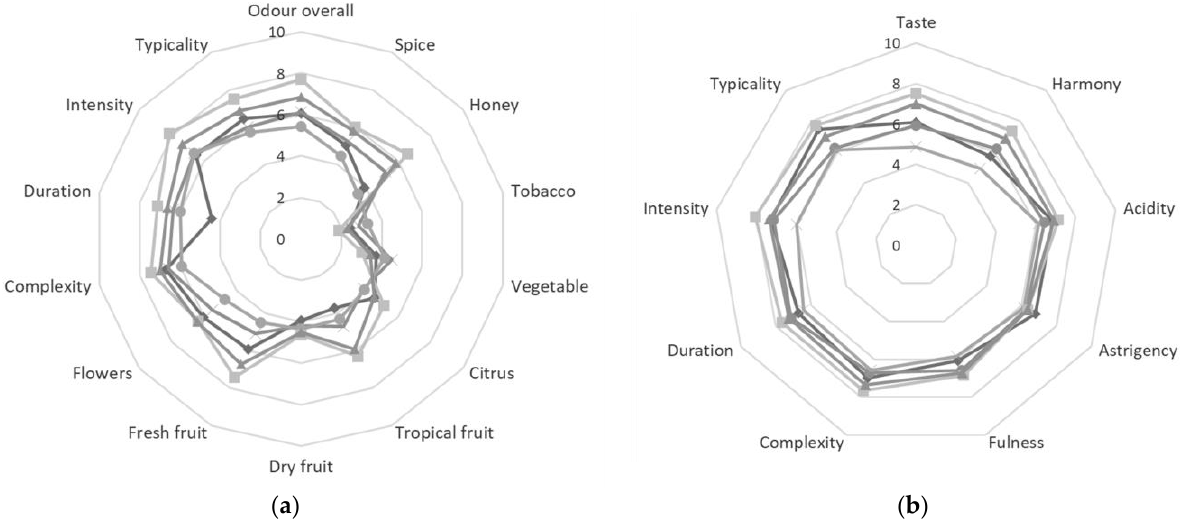
Figure 1. Sensory analysis of ( a ) smell and ( b ) taste profile of wines produced without maceration and fermented with C. famata WB-1 ( ■ ), C. famata WB-1 + S. cerevisiae QA23 ( ▲ ), M. pulcherrima B-5